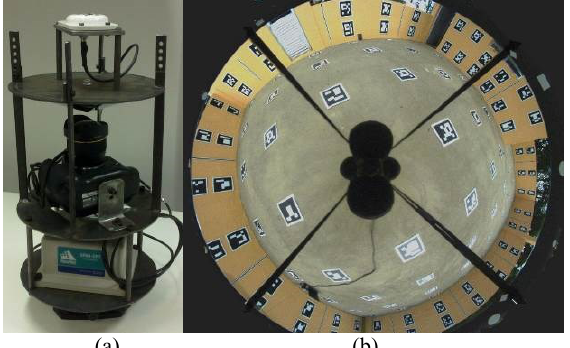
Figure 7 – (a) Catadioptric omnidirectional vision system and (b) an image from the 3D calibration